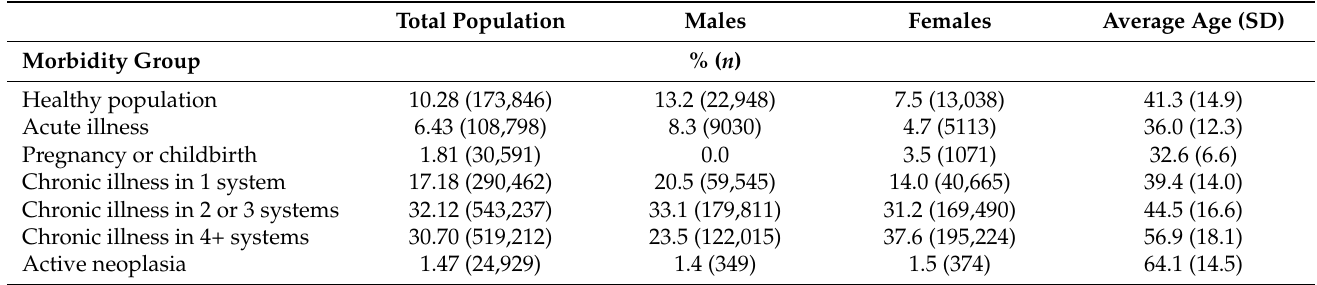
Table 1. Distribution of the population by morbidity group, sex and average age. Total Population Males Females Average Age (SD) % ( n